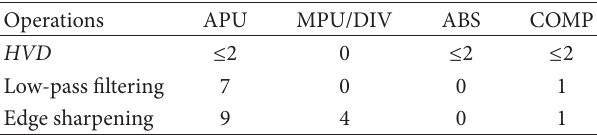
Table 2: Operation counts of the proposed